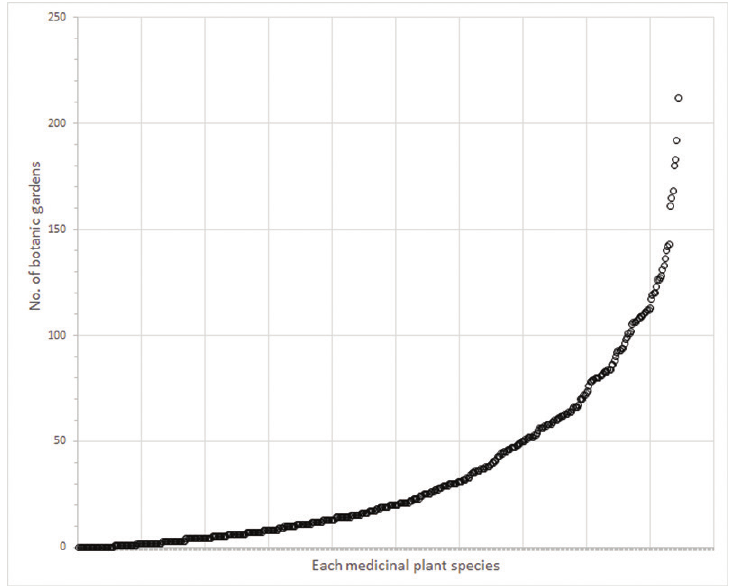
Figure 2. The number of botanic gardens worldwide that have digitally recorded accessions of each of the 472 medicinal plant species treated in this